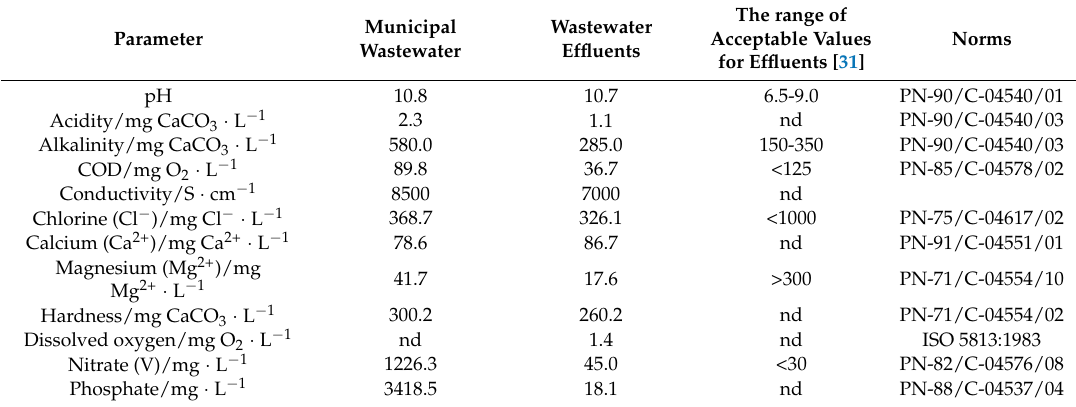
Table 3. Municipal wastewater and wastewater effluents